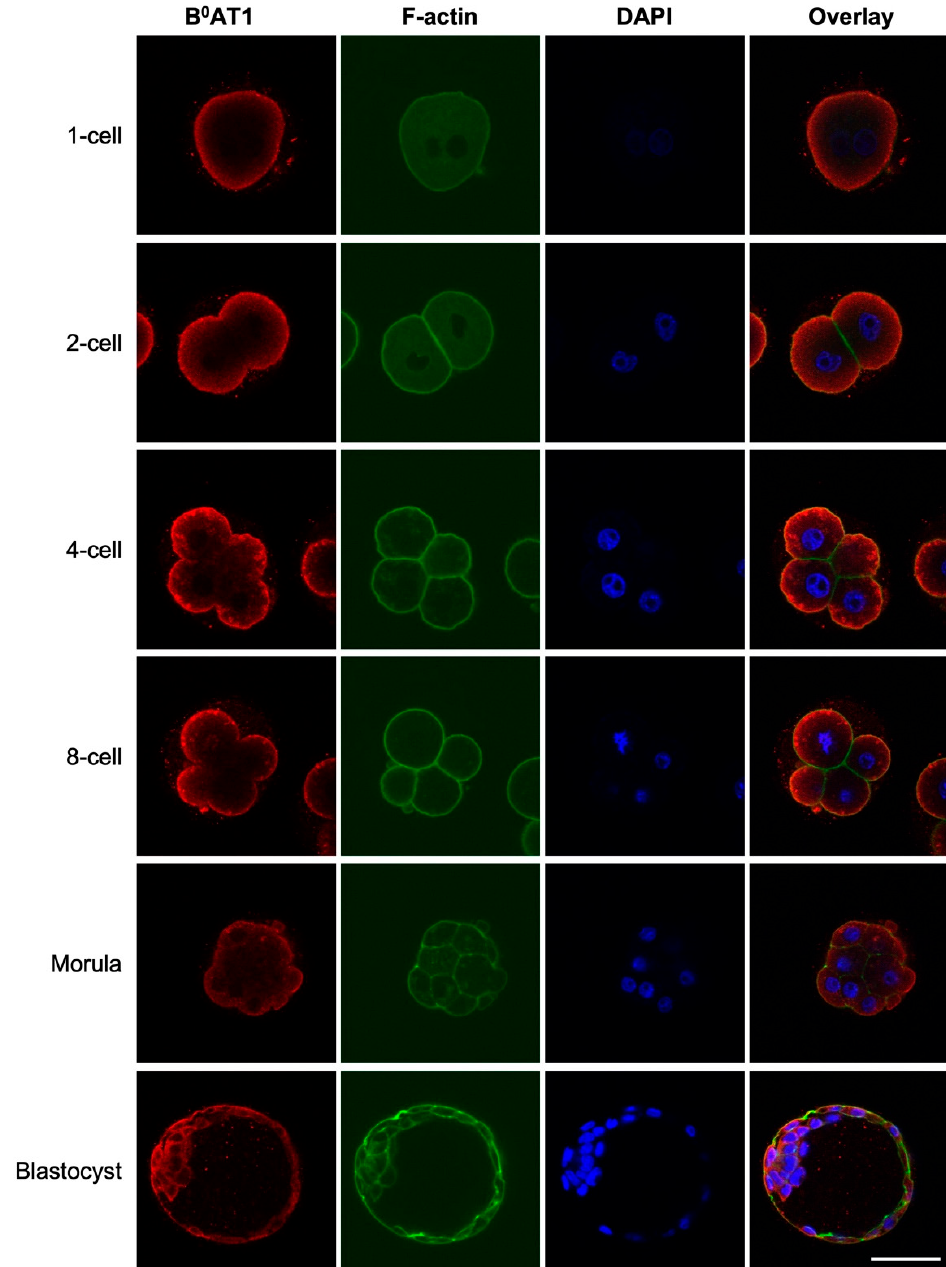
Figure 1. B 0 AT1 is expressed throughout preimplantation mouse embryo development. Embryos from QS mice were freshly isolated at 1-, 2-, 4-, and 8-cell, morula and blastocyst stages, fixed and immunostained for B 0 AT1 (red) and counterstained for F-actin with phalloidin (green) and nuclei with DAPI (blue). Fluorescent images were captured by confocal microscopy using a 40x objective. No staining was observed when a pre-immune IgY equivalent was used as a negative control for B 0 AT1 staining (not shown). Scale bar = 50 μ m for all images.